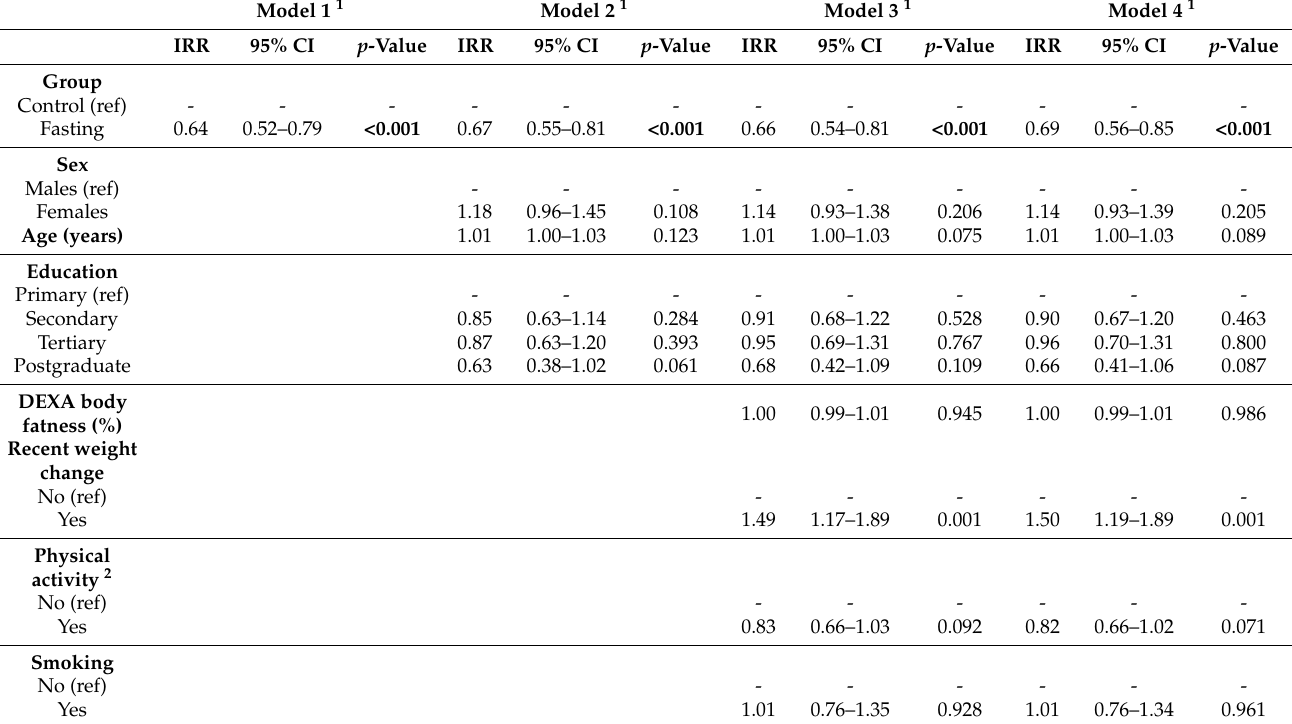
Table 4. Negative binomial regression analysis for GDS